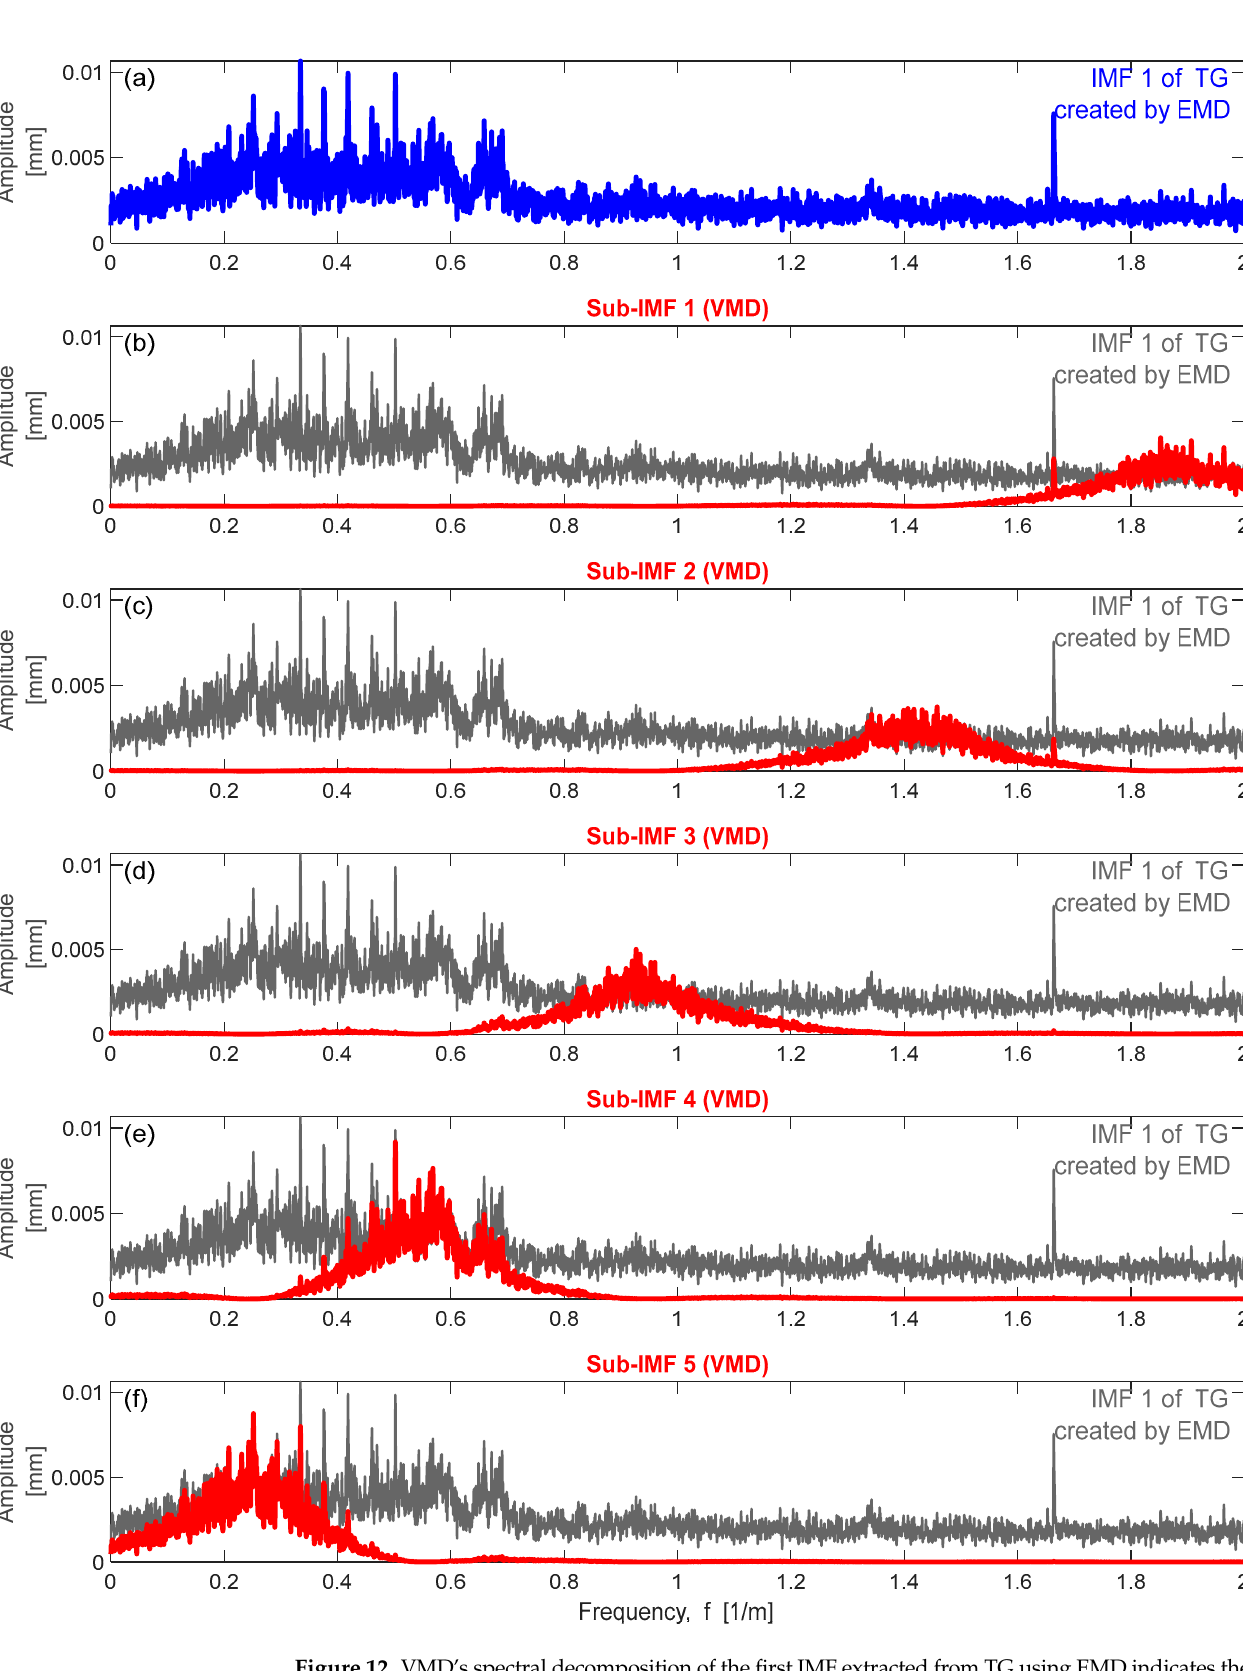
Figure 11. VMD’s spectral decomposition of the fi rst IMF extracted from ALL using EMD indicates the inherent sub-IMF components (track section No. 4). ( a ) IMF of ALL created by EMD; ( b ) Sub-